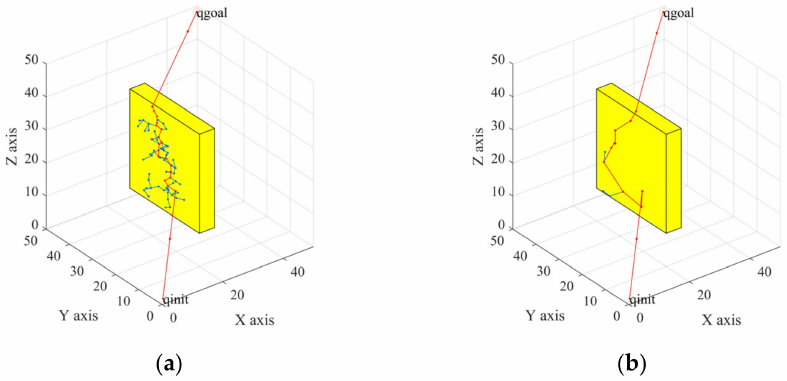
Figure 6. Differences before and after improvement. ( a ) The random trees generated a large number of nodes on the surface of obstacles; ( b ) The random tree had fewer nodes on the obstacle surface.